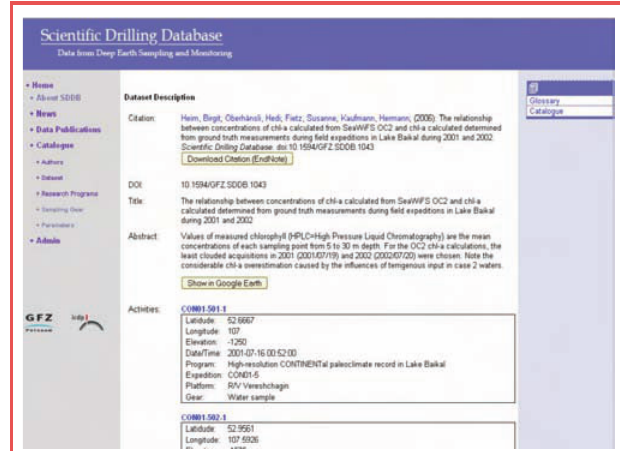
Figure 1. Screenshot of a data citation in SDDB. Note the buttons for download of citation into a reference manager and for the visualization of sampling locations in Google Earth. The Digital Object Identifier of this dataset is